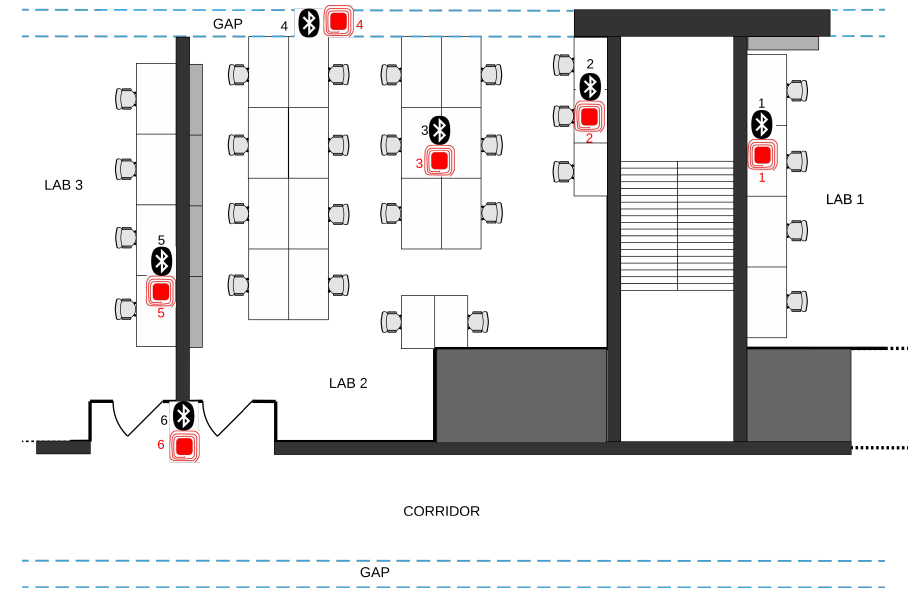
Figure 15. Case study